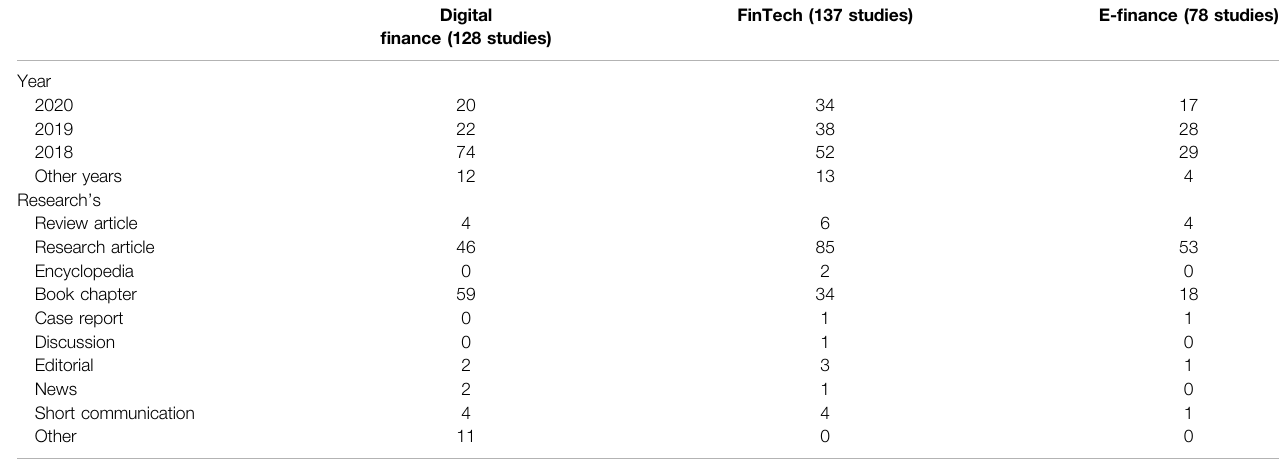
TABLE 1 | Statistics of previous studies.